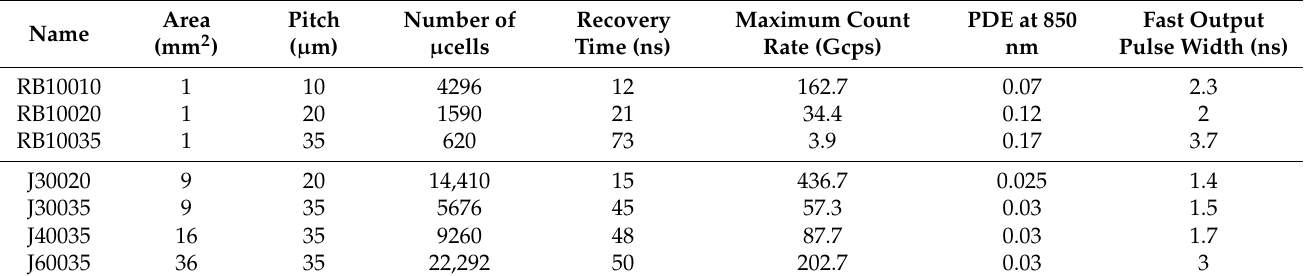
Table 3. Key parameters for the two series of commercially available SiPMs manufactured by onsemi, including their PDE at 850 nm [22,24,25].